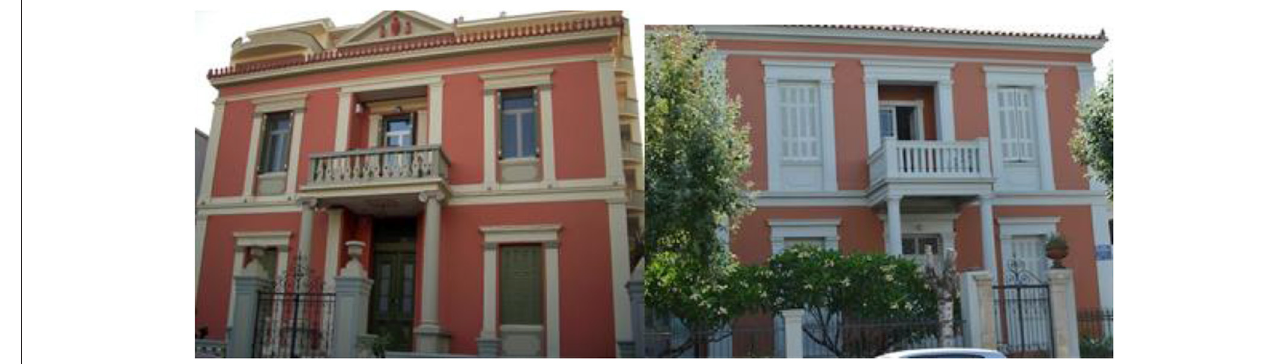
FIGURE 1 | Typical masonry buildings in Chania, Crete, Greece.